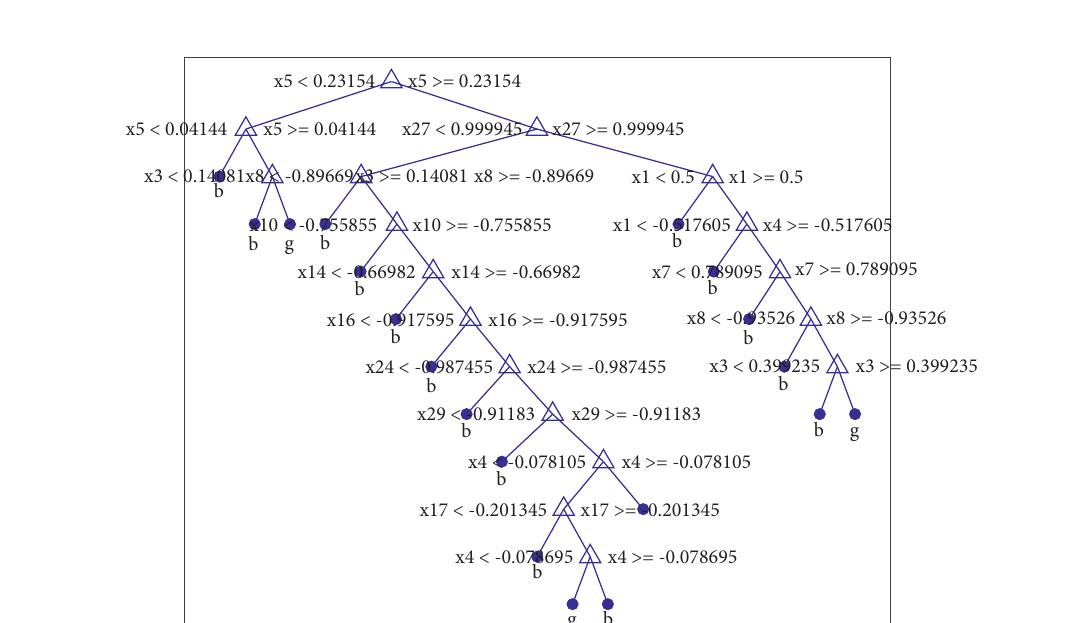
Figure 2: Specific clustering classification.